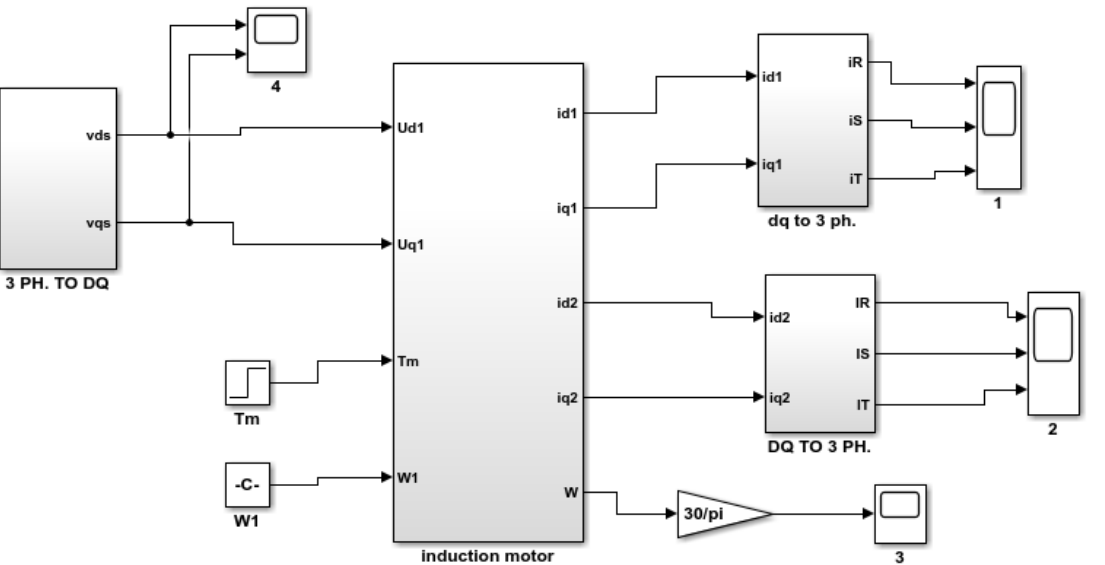
Figure 2. Simulink model of a 3-phase induction motor under normal conditions.